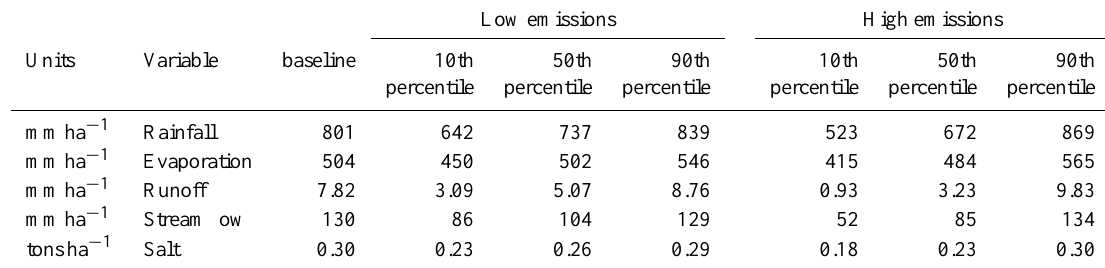
Table 4. Modelled mass balances (average annual) under baseline and climate change